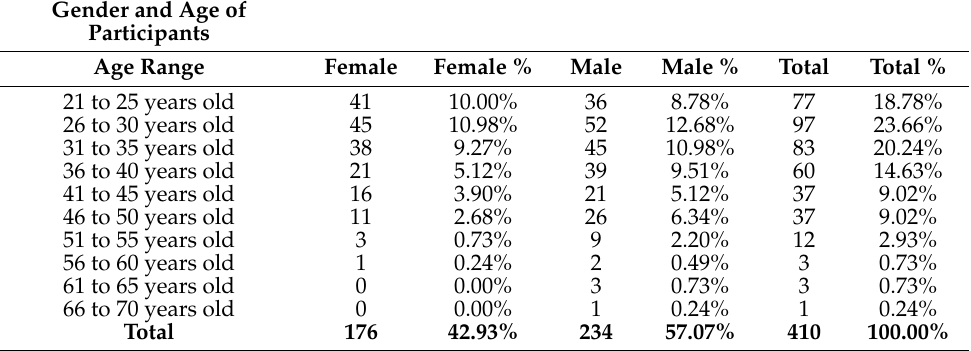
Table 3. Gender and age of sample participants combined.